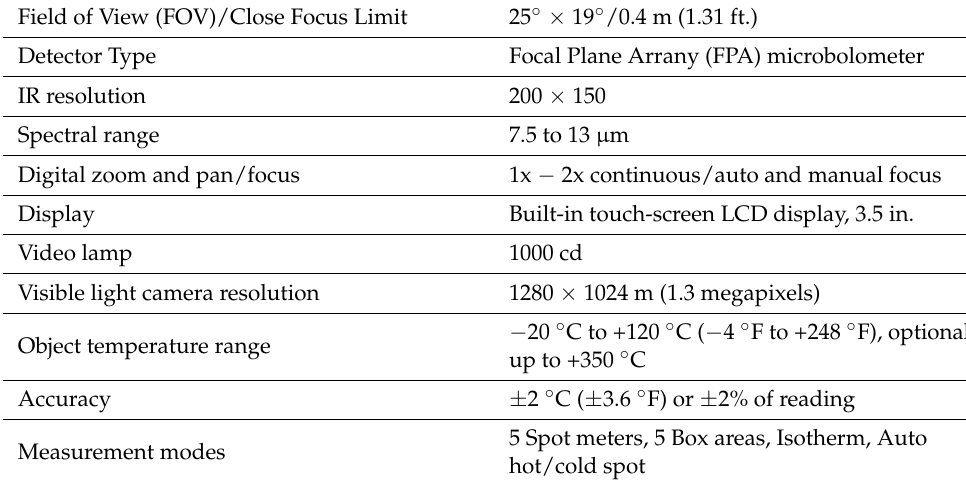
Table 1. Characteristics of the thermographic